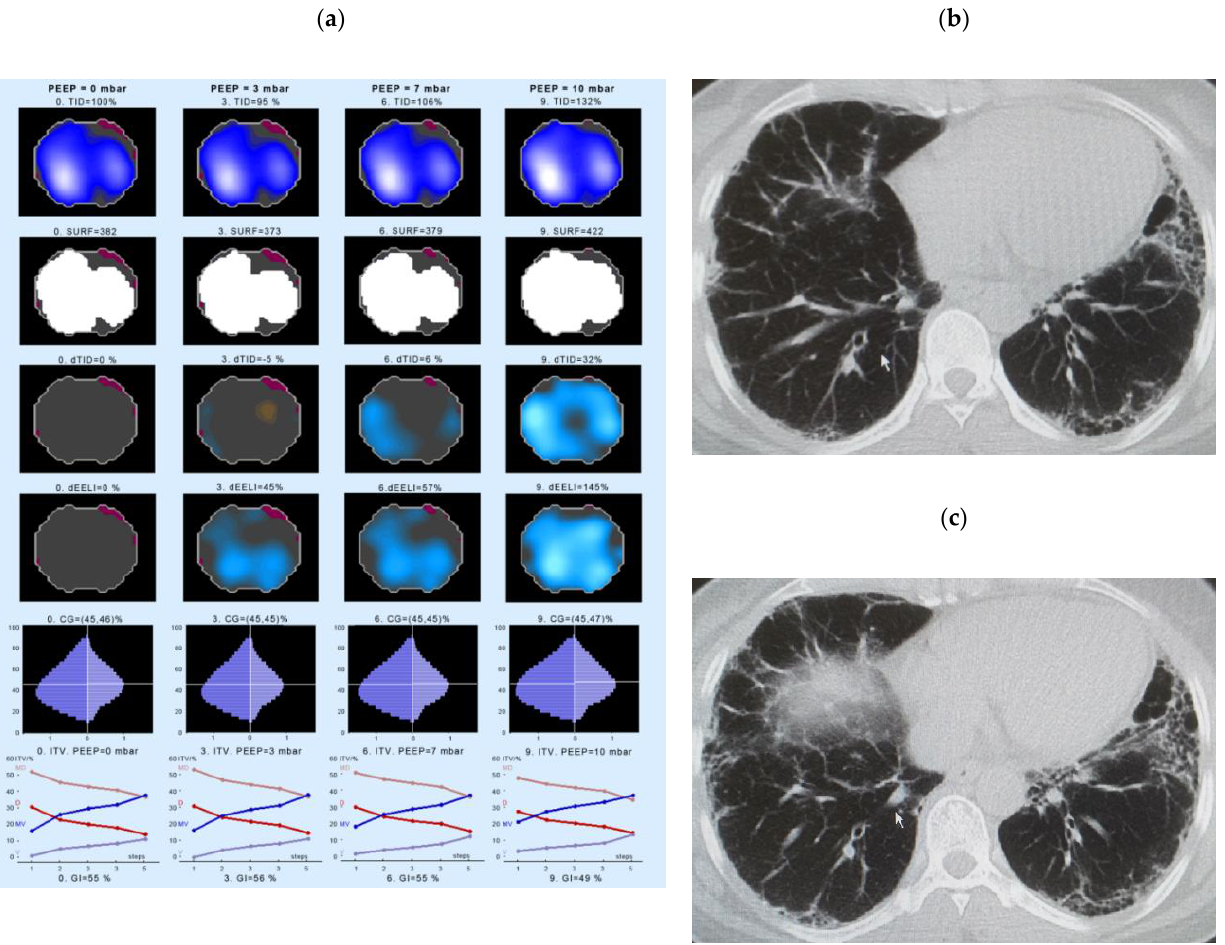
Figure 3. Changes in regional lung ventilation in IPF patient #4. Left panel ( a ): Spatial distribution of TID, SURF, dTID, dEELI in the electrical impedance (EI) tomogram at a PEEP of 0 (left), 3 (2nd left), 7 (3rd from left), and 10 cm H 2 O levels (right column). The lowest panel indicates the intratidal gas distribution (ITV) for four anatomical areas during one respiration. Given are the distribution of ventilation into the ventral (V), dorsal (D), medio-ventral (MV) and medio-dorsal (MD) regions of the lung. The X scale (1–5) shows the entire inspiration, divided into 5 steps. Right panel ( b , c ): The respective high resolution CT picture corresponding to the ROI of EIT measurement is shown. Abbreviations: CG—center of gravity of ventilation distribution; dEELI—difference of end-expiratory lung impedance over time; ITV—intratidal gas distribution; PEEP—positive end-expiratory pressure; SURF—surface of ventilated areas, TID—tidal impedance distribution; dTID—difference of TID over